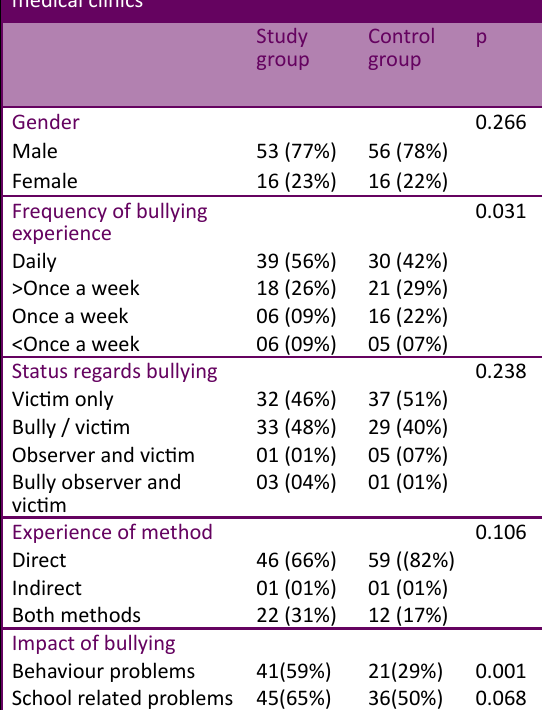
Table 1 – Comparison of variables related to bullying between children attending mental health clinics